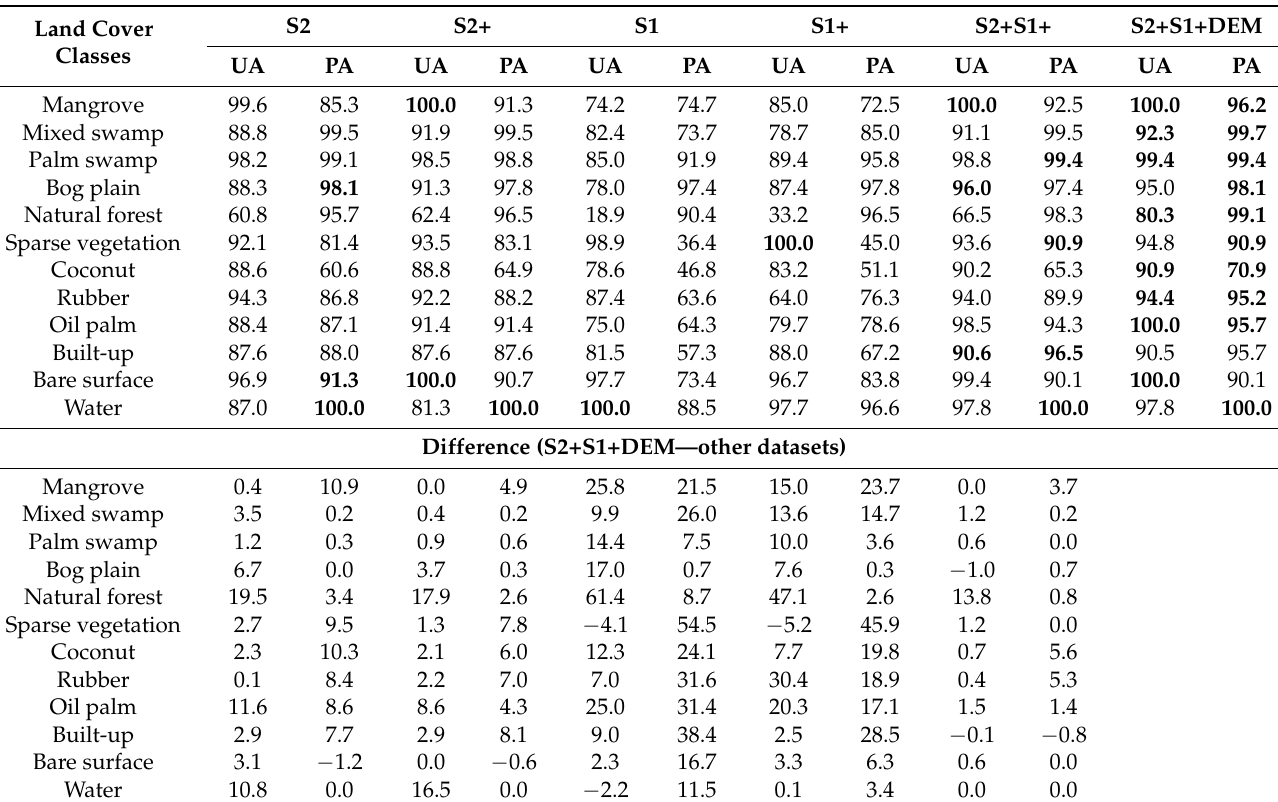
Table 6. Producer’s accuracy (PA) and user’s accuracy (UA) of land cover classes for all datasets, and the difference in UA and PA between S2+S1+DEM and each of the other datasets. Negative values indicate lower UA and PA for S2+S1+DEM compared to the other datasets. The best UA and PA values for each class are in